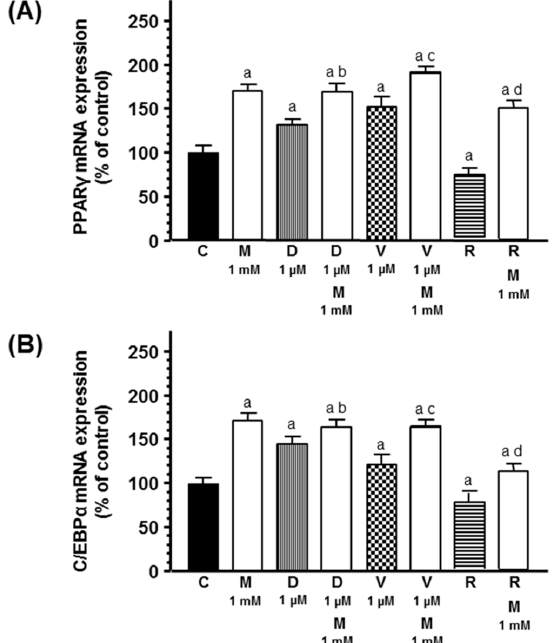
Figure 6. Effects of melatonin on docetaxel-, vinorelbine-, and radiation-induced changes on (A) PPAR γ and (B) C/EBP α mRNA expression. Data are expressed as the percentage of control group (mean ± SEM). a, p < 0.01 vs. C; b, p < 0.05 vs. D (1 µM); c, p < 0.01 vs. V (1 µM); d, p < 0.01 vs. R. C: control, M: melatonin, D: docetaxel, V: vinorelbine, R: radiation.